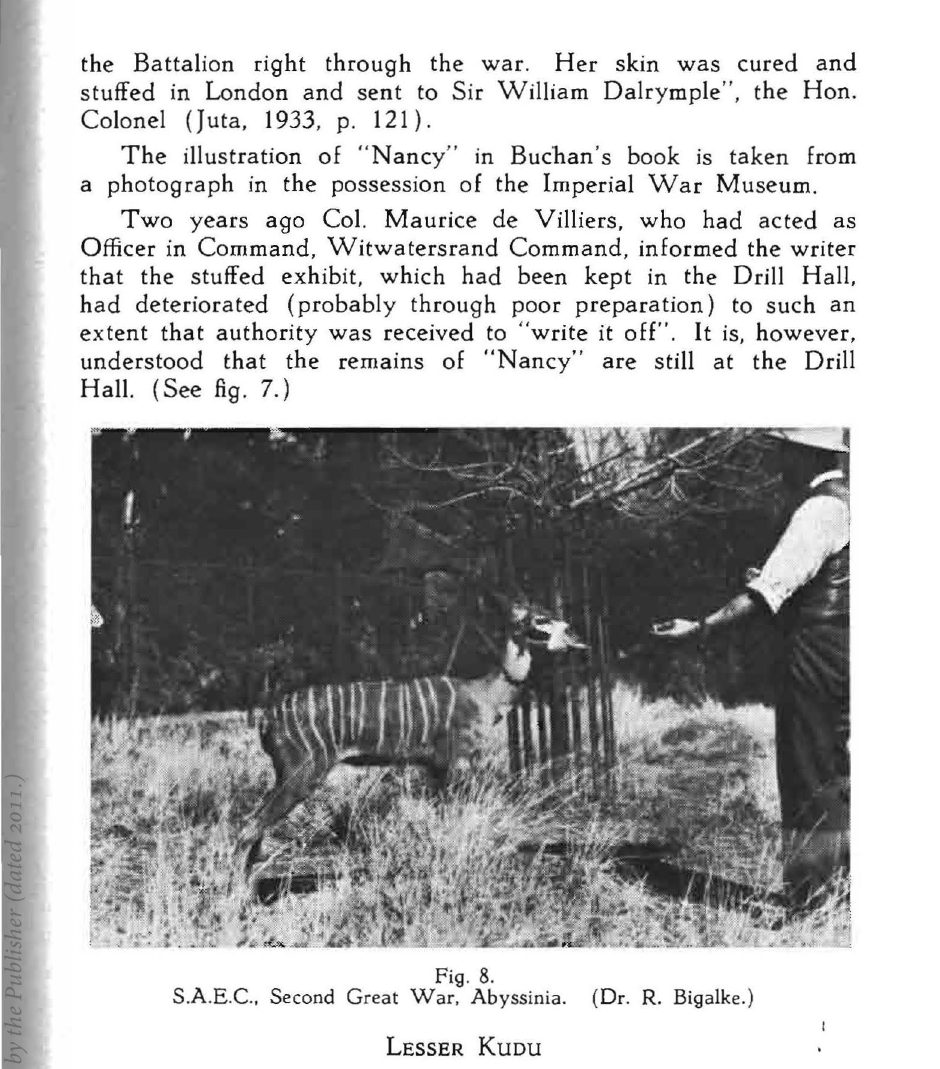
Fig. 8. S.A.E.C., Second Great War, Abyssinia. (Dr. R.